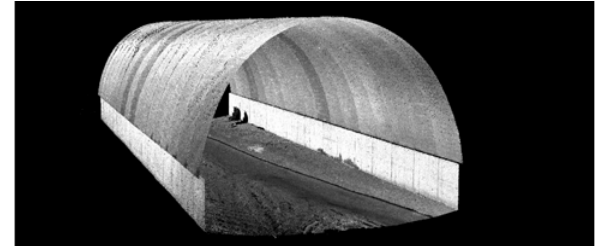
Figure 4. Geo-referenced point cloud of the underpass after filtering the backfill.